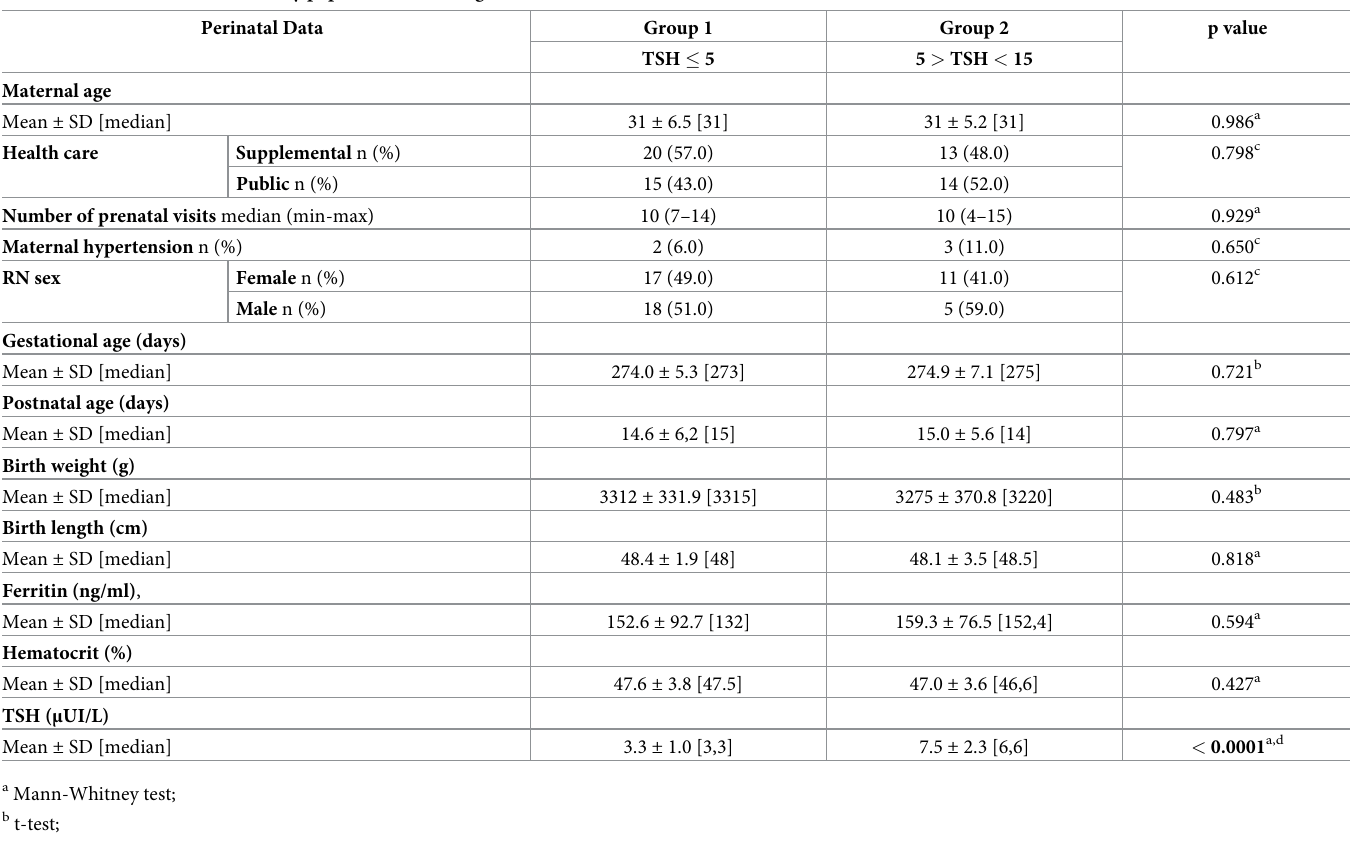
Table 1. Characteristics of the study population according to TSH levels. Perinatal Data Group